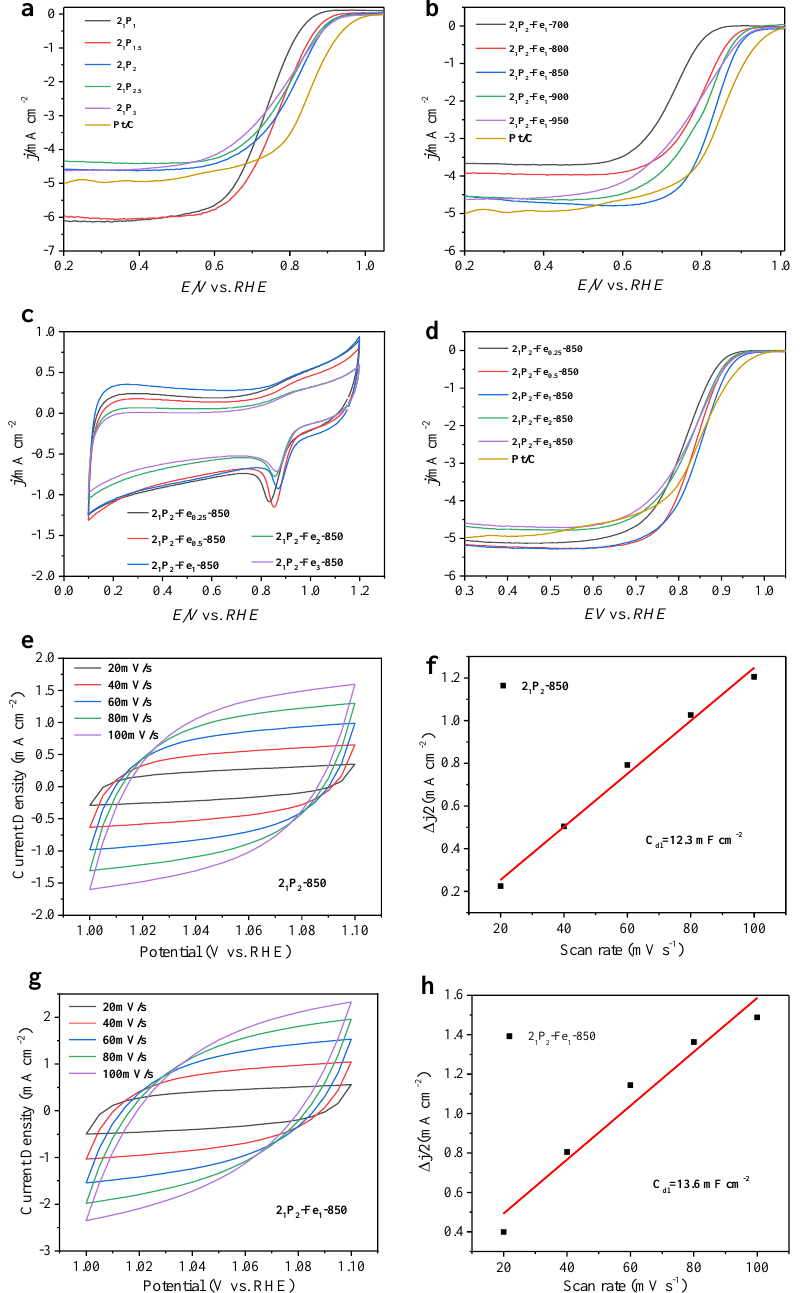
Figure 1. Cyclic voltammetry and linear sweep voltammetry curves of the catalysts and Pt/C ( a ) with different 2-methylimidazole and PTFE ratios; ( b ) with different pyrolysis temperatures; ( c , d ) with different metal contents; CV curves at different scan rates ( e , g ) and corresponding capacitive ∆ j at the potential of 1.05 V (vs. RHE) plots to estimate the electrochemical double-layer capacitances (C dl ) for ( f ) 2 1 P 2 -850, ( h ) 2 1 P 2 -Fe 1 -850.